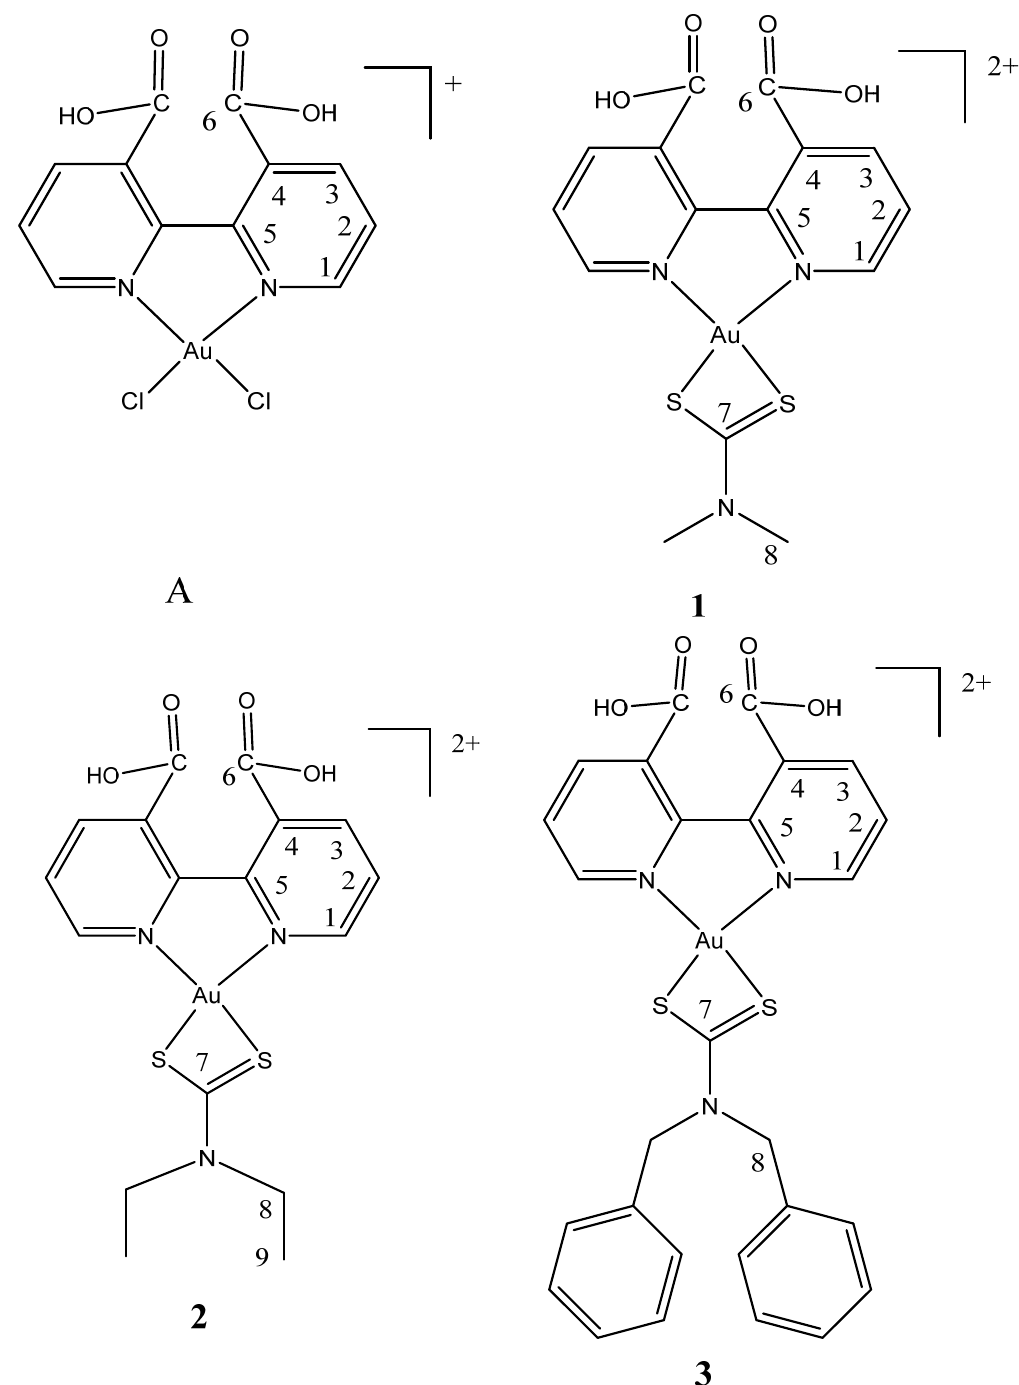
Scheme 1. The possible structures of gold(III) complexes along with resonance assignment. In all cases, counter ions are chloride.